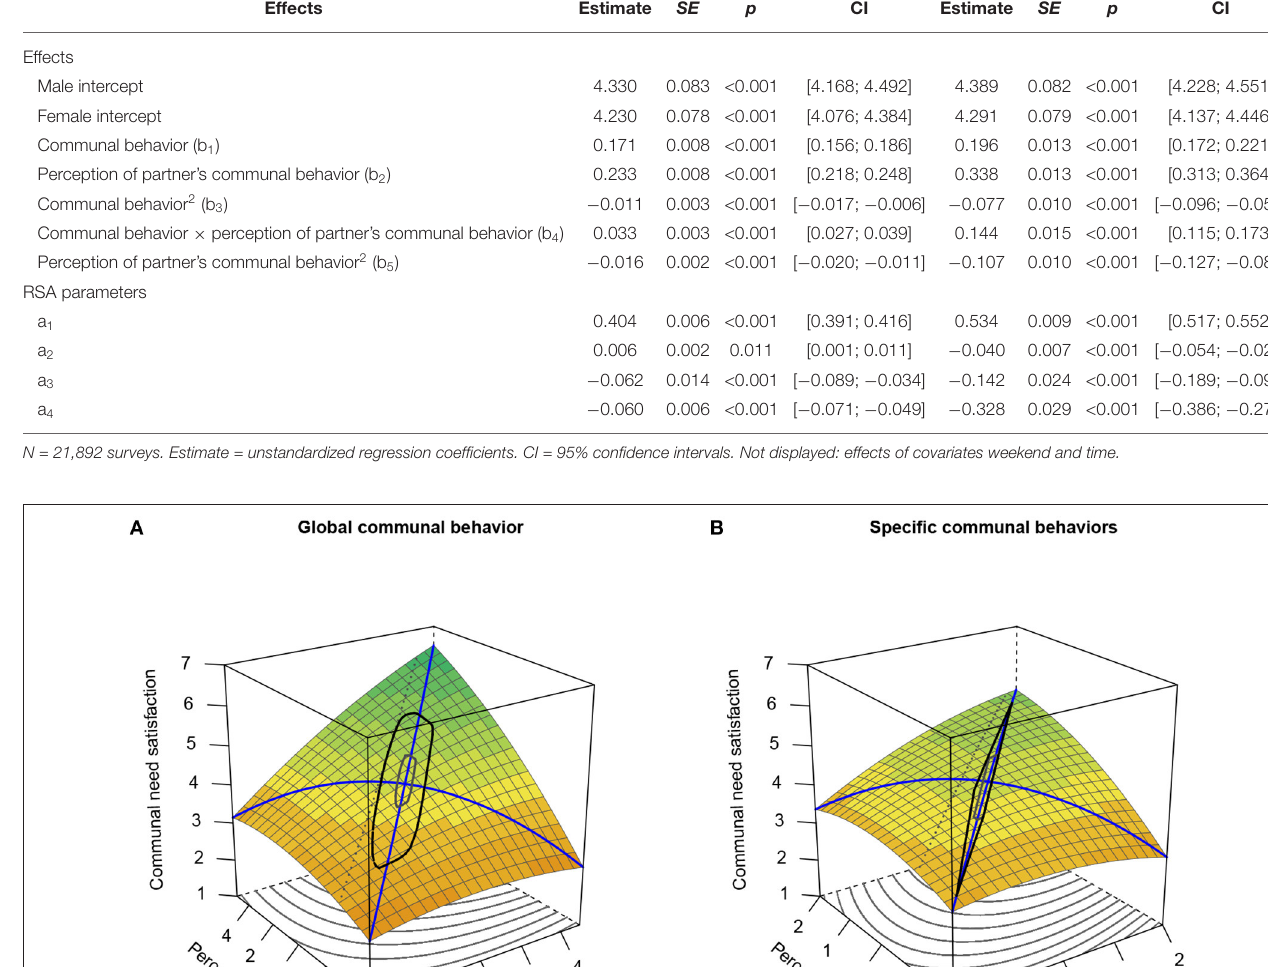
Global communal behavior